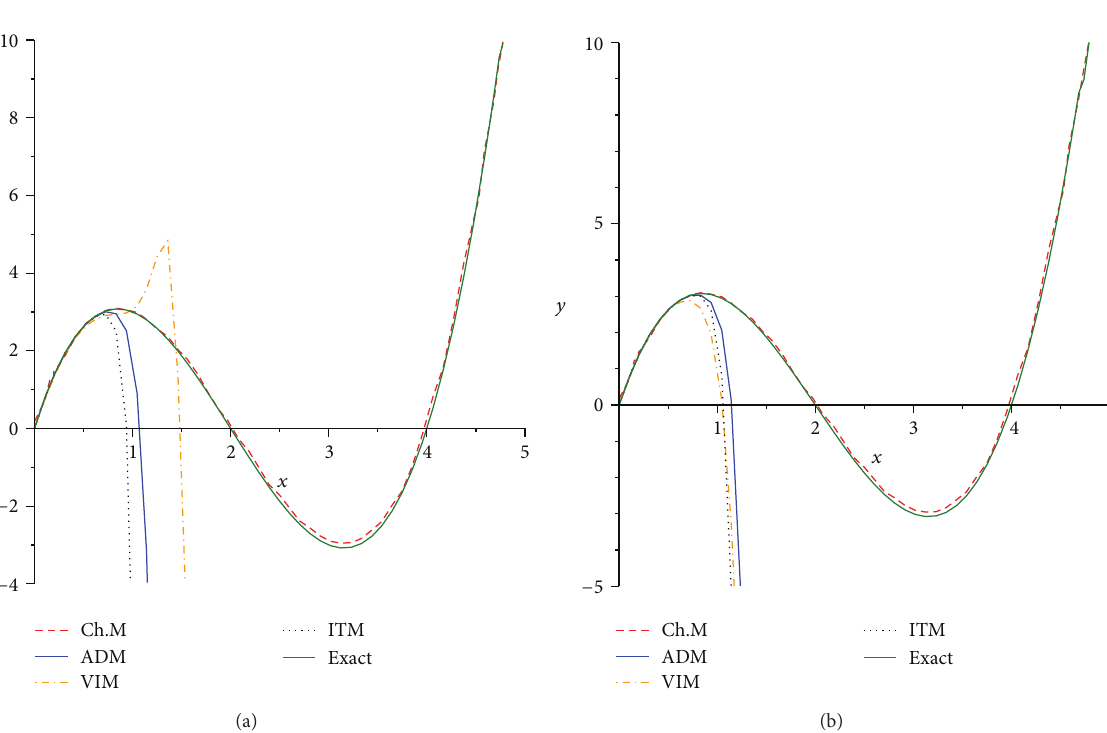
Figure 6: Numerical solutions of Example 3, for some values of 𝑚 .